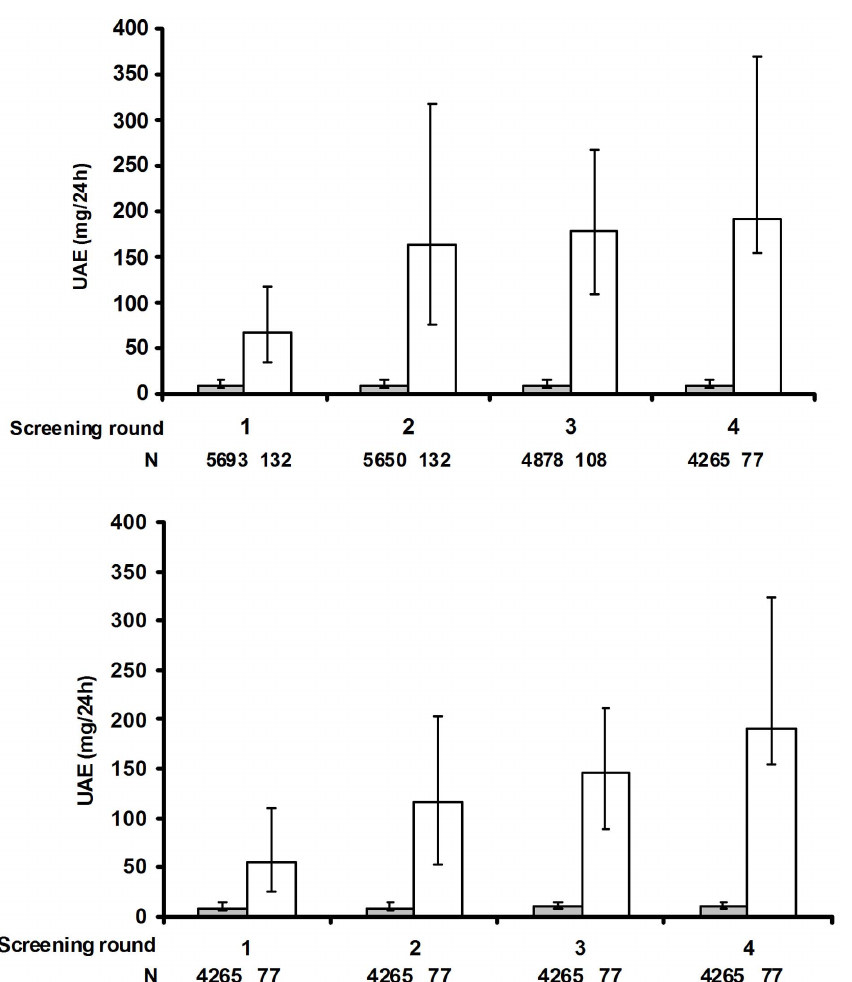
Figure 1. Median (IQR) urinary albumin excretion (UAE) of subjects meeting the definition of progressive albuminuria (open bars) and subjects without progressive albuminuria (dark bars) during the various screening rounds of the PREVEND cohort. The upper panel shows data of all participants, whereas the lower panel shows data of only participants with follow-up until the last screening. Abbreviations: N denotes the number of